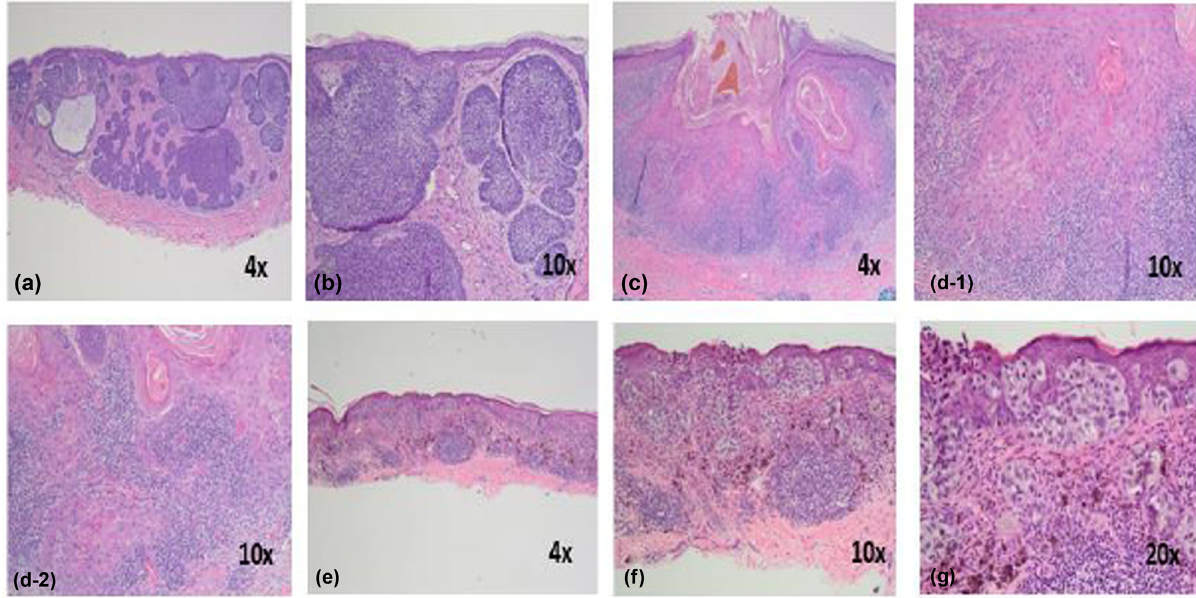
Figure 1: The characteristic histology of di ff erent forms of skin cancer: basal cell carcinoma: ( a ) nodular masses of basaloid cells extend into the dermis with peritumoral stroma ( 4 ×) ; ( b ) closer magni fi cation highlights the peripheral palisading and tumor retraction artifact ( 10 ×) ; squamous cell carcinoma: ( c ) scanning magni fi cation highlights a crater - like tumor with irregular masses of atypical keratinocytes invading the dermis. A pronounced surrounding in fl ammatory in fi ltrate is seen ( 4 ×) ; ( d - 1 ) and ( d - 2 ) invading tumor masses with atypical keratinocytes, dyskeratotic cells, and keratin pearls ( 10 ×) ; melanoma: ( e ) scanning magni fi cation reveals a broad, atypical melanocytic proliferation which is asymmetric and poorly circumscribed ( 4 ×) ; ( f ) the epidermal proliferation is characterized by variably sized nests at and above the dermoepidermal junction. A robust lymphocytic in fl ammatory response is present ( 10 ×) ; ( g ) closer magni fi cation again reveals nests at and above the dermoepidermal junction. The lesional cells are atypical, and single melanocytes are noted at all levels of the epidermis in a pagetoid arrangement ( 20 ×) ( photographs